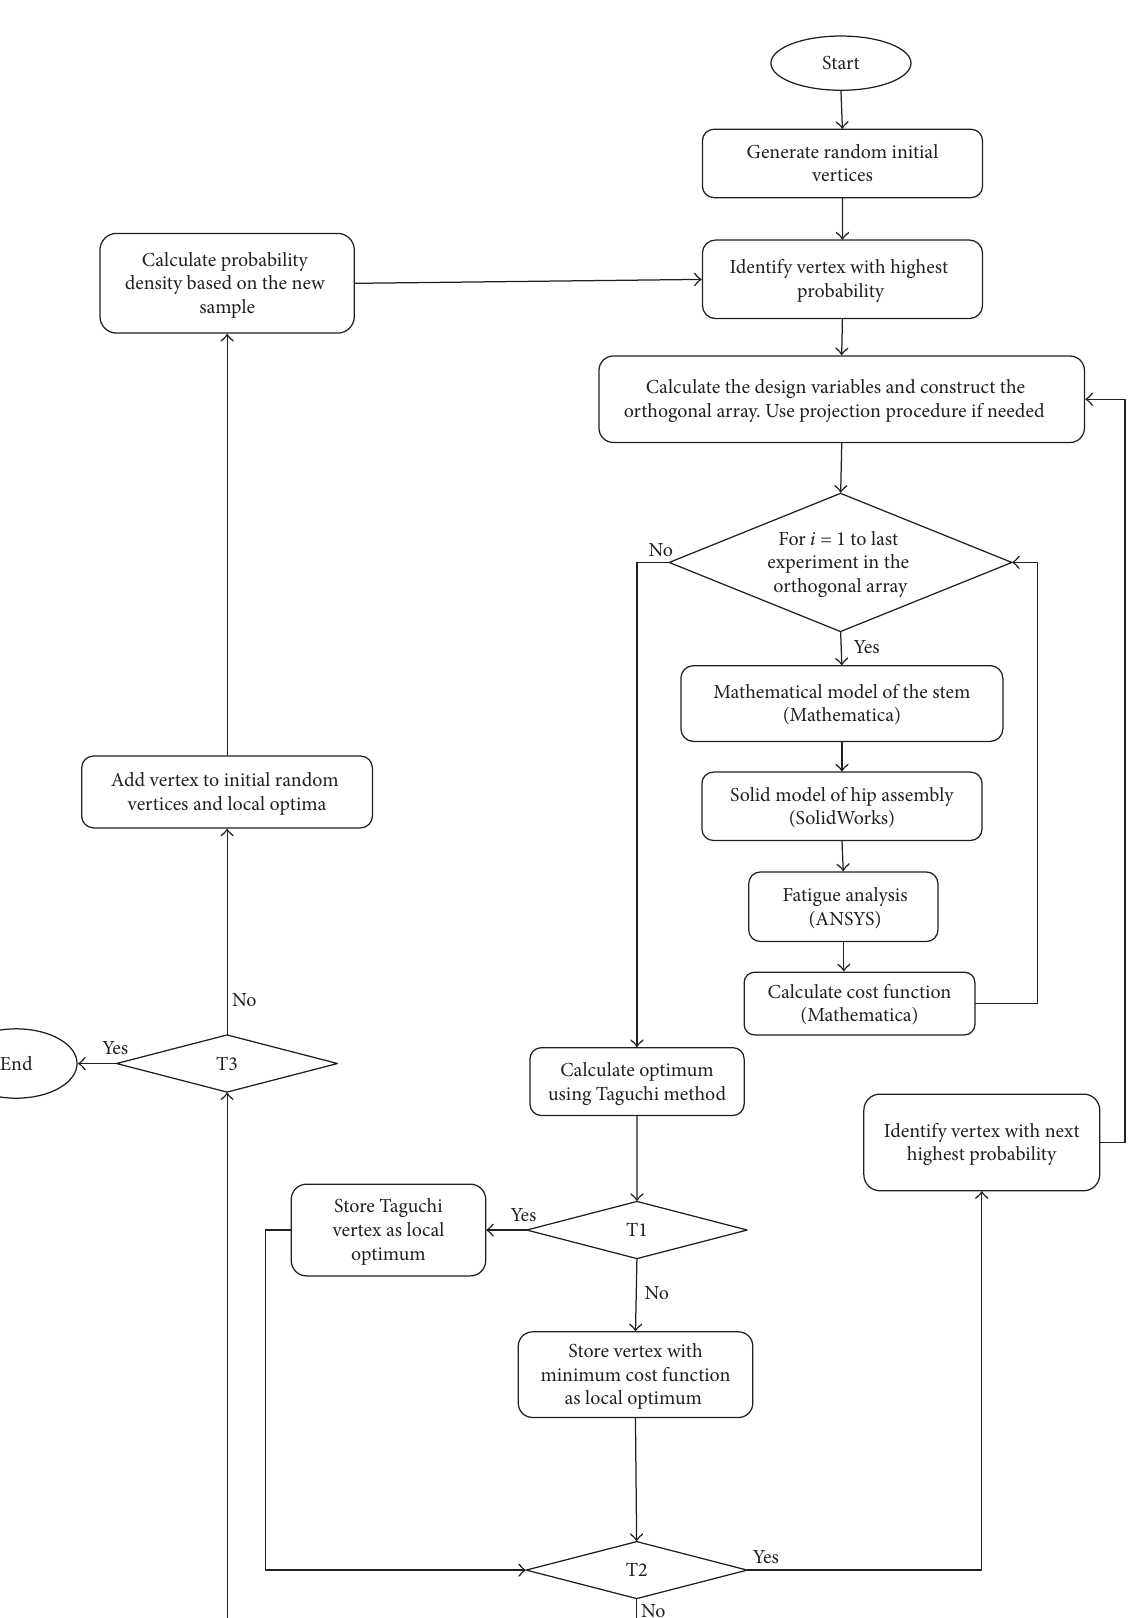
Figure 8: Global optimization. T1: Taguchi suggested optimum is best; T2: already known as an optimum; T3: maximum number of analyses is